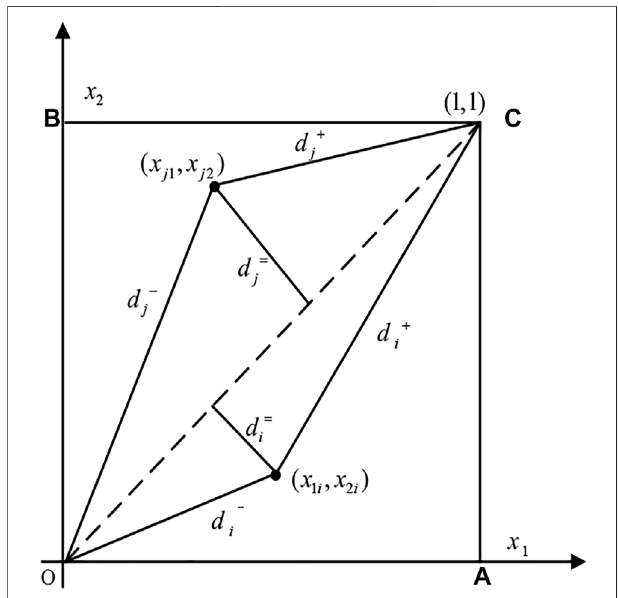
FIGURE 6 | Three distances of Program i and program j